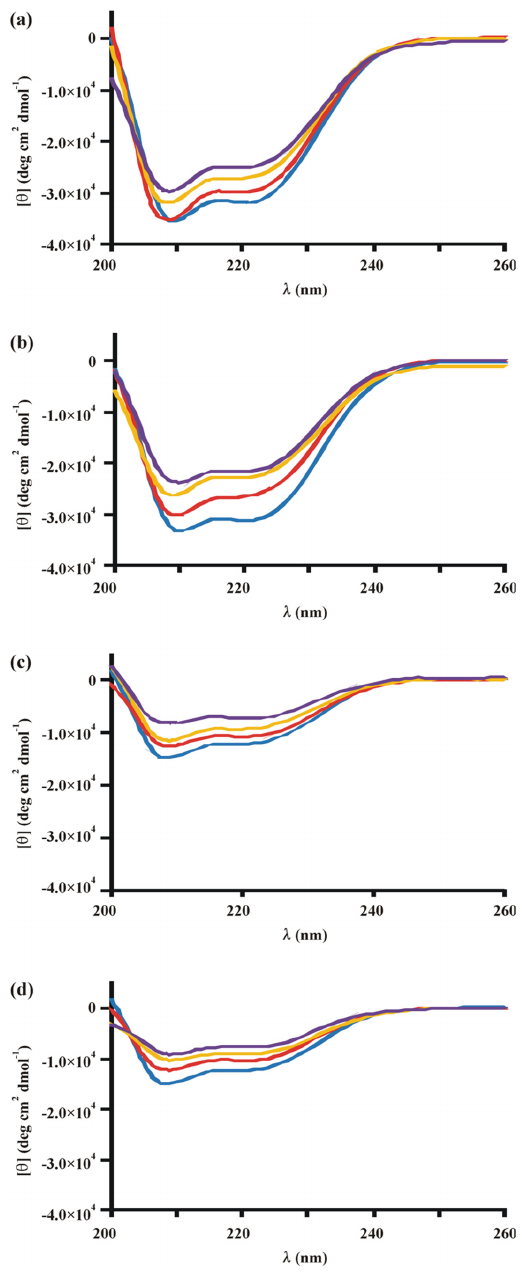
Figure 4. CD analyses of Xyr1 and Xyr1 A824V in the presence of carbohydrates. Far-UV spectra (200–260 nm) of Xyr1 ( a , b ) or Xyr1 A824V ( c , d ) in the presence of D-glucose-6-phosphate ( a , c ) or D-xylose ( b , d ) applying molar ratios (protein to carbohydrate) of 1:0 (blue lines), 5:1 (red lines), 1:1 (yellow lines), and 1:5 (purple lines). Data were plotted after correction for the contribution of the